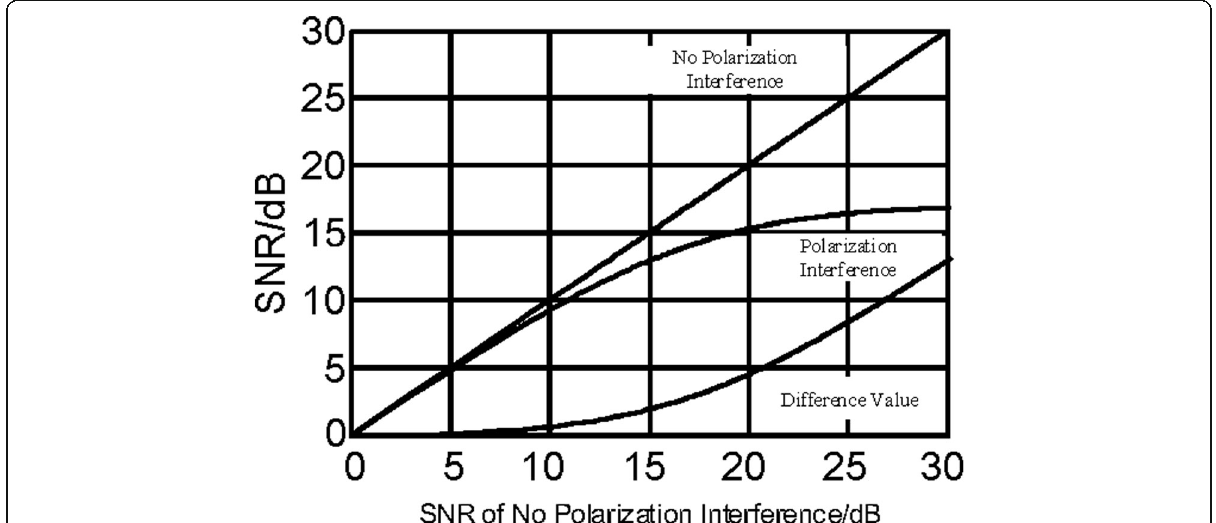
Fig. 4 Deterioration of E b / N 0 in case of QPSK without channel coding. This figure shows a graph of deterioration of E b / N 0 in case of QPSK without channel coding, a =